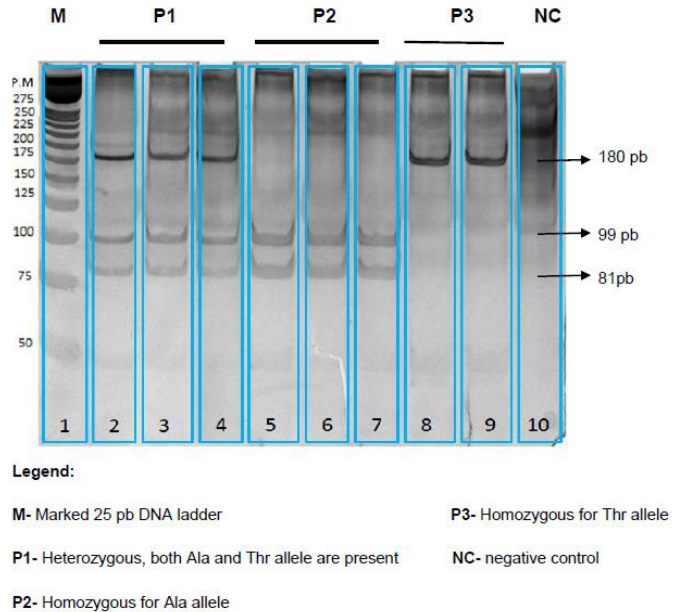
Figure 1. Genotyping of the FABP2 (rs1799883) Ala54Thr polymorphism. After digestion of the polymerase chain reaction PCR product with Hha I in a polyacrylamide-gel electrophoresis stained with silver nitrate, P1 samples heterozygotes have three bands, at 180 bp, 99 bp and 81pb, P2 homozygotes have two bands at 99 bp and 81 bp. P3 homozygotes have one band at 180 bp.